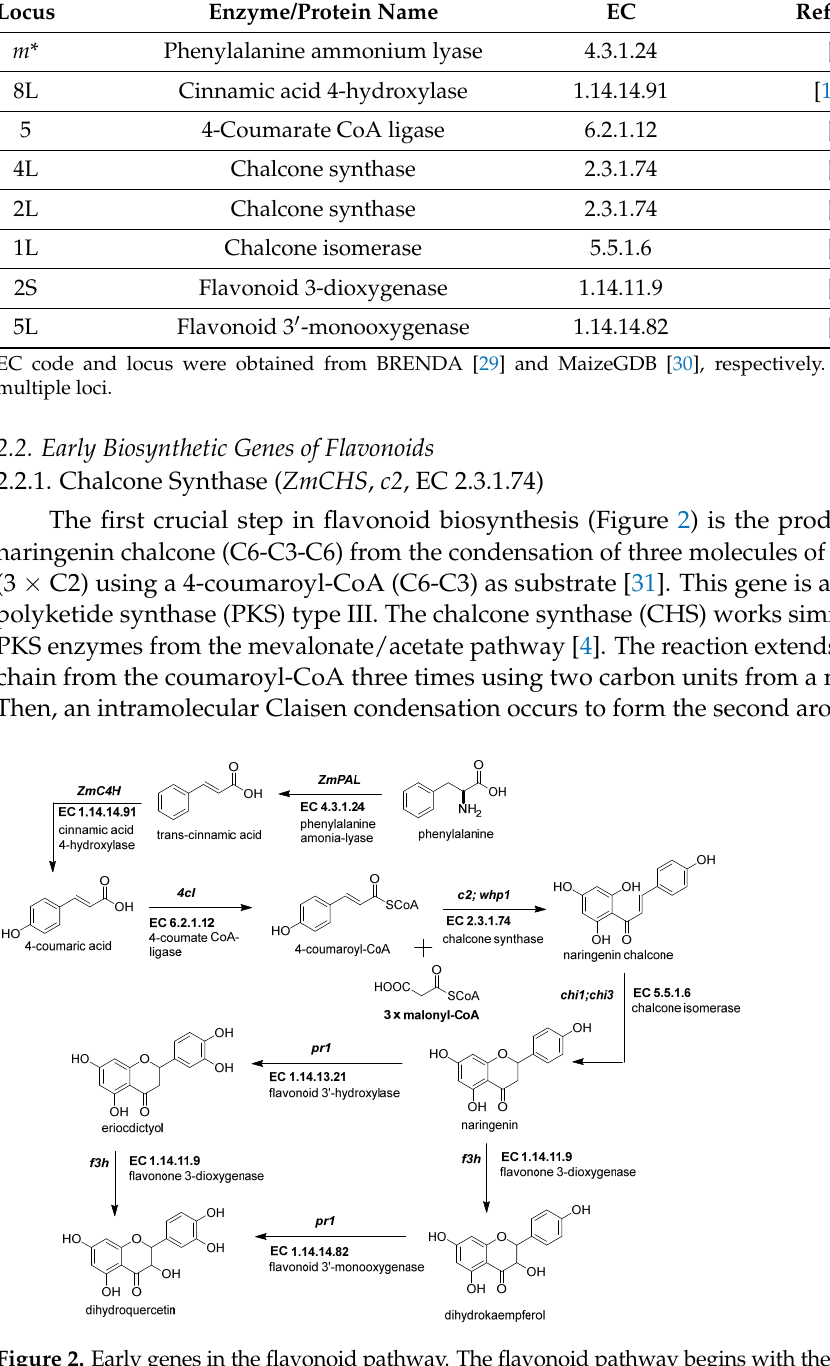
Figure 2. Early genes in the flavonoid pathway. The flavonoid pathway begins with the transfor- mation of phenylalanine to coumaroyl-CoA. The last steps end with the intravacuolar accumulation of acylated anthocyanins. The genes responsible for supplying the coumaroyl-CoA into the flavo- noid pathway are phenylalanine ammonium lyase ( ZmPAL , EC 4.3.1.24), cinnamic acid 4-hydrox- ylase ( ZmC4H , EC 1.14.14.91), and 4-coumarate CoA ligase ( Zm4CL , bm5 , EC 6.2.1.12). The flavonoid genes are divided into early biosynthetic genes ( EBGs ) and late biosynthetic genes ( LBGs ). EBGs comprise four genes: chalcone synthase ( ZmCHS , c2 , EC 2.3.1.74), chalcone isomerase ( ZmCHI , chi1 , EC 5.5.1.6), flavonoid 3-dioxygenase ( ZmF3H , fht1 , EC 1.14.11.9), and flavonoid 3 ′ -monooxygenase ( ZmF3 ′ H , pr1 , EC 1.14.14.82). References: [30,32]. Genome-wide analysis revealed up to 15 ZmCHS genes in the maize genome (Han et al., 2016). However, the members more consistently studied are the duplicated c2 ( ZmCHS01 ) and whip1 ( ZmCHS02 ) genes (Table 1) [24]. Multiple tissues, including tassels, ear husks, and aleurone layer of endosperm at different developmental stages, express the genes c2 and whip1 [33,34]. Indeed, functional alleles for genes c2 and whip1 are vital to increasing the biosynthesis of any flavonoids downstream, such as apigenin and tricin, essential for lignin formation, and C-glycosyl flavones [25,35]. Meanwhile, members of the chalcone synthase family, such as ZmCHS013 and ZmCHS014 , compared to ZmCHS01 , had a lower expression in most tissues and different responses under the stimuli of sali- cylic acid [36]. 2.2.2. Chalcone Isomerase ( ZmCHI , chi1 , EC 5.5.1.6) This enzyme catalyzes an intramolecular Michael-type addition from the chalcone 2- O to its α , β -unsaturated carbonyl (Figure 2). The final product is the typical phenyl-chro- manone or flavanone structure [4]. The first gene sequenced from this family in maize was ZmCHI (Table 1) [26]. Interestingly, mutants have not been reported in maize for this gene, due to the multiple homologous sequences found for ZmCHI in the maize genome. An experiment designed to find QTLs for resistance to Fusarium corn fungi detected ZmCHI3 as a second member of the family [37]. Indeed, a transformed maize callus with a copy of ZmCHI3 from a resistant inbred was less susceptible to maize plagues.